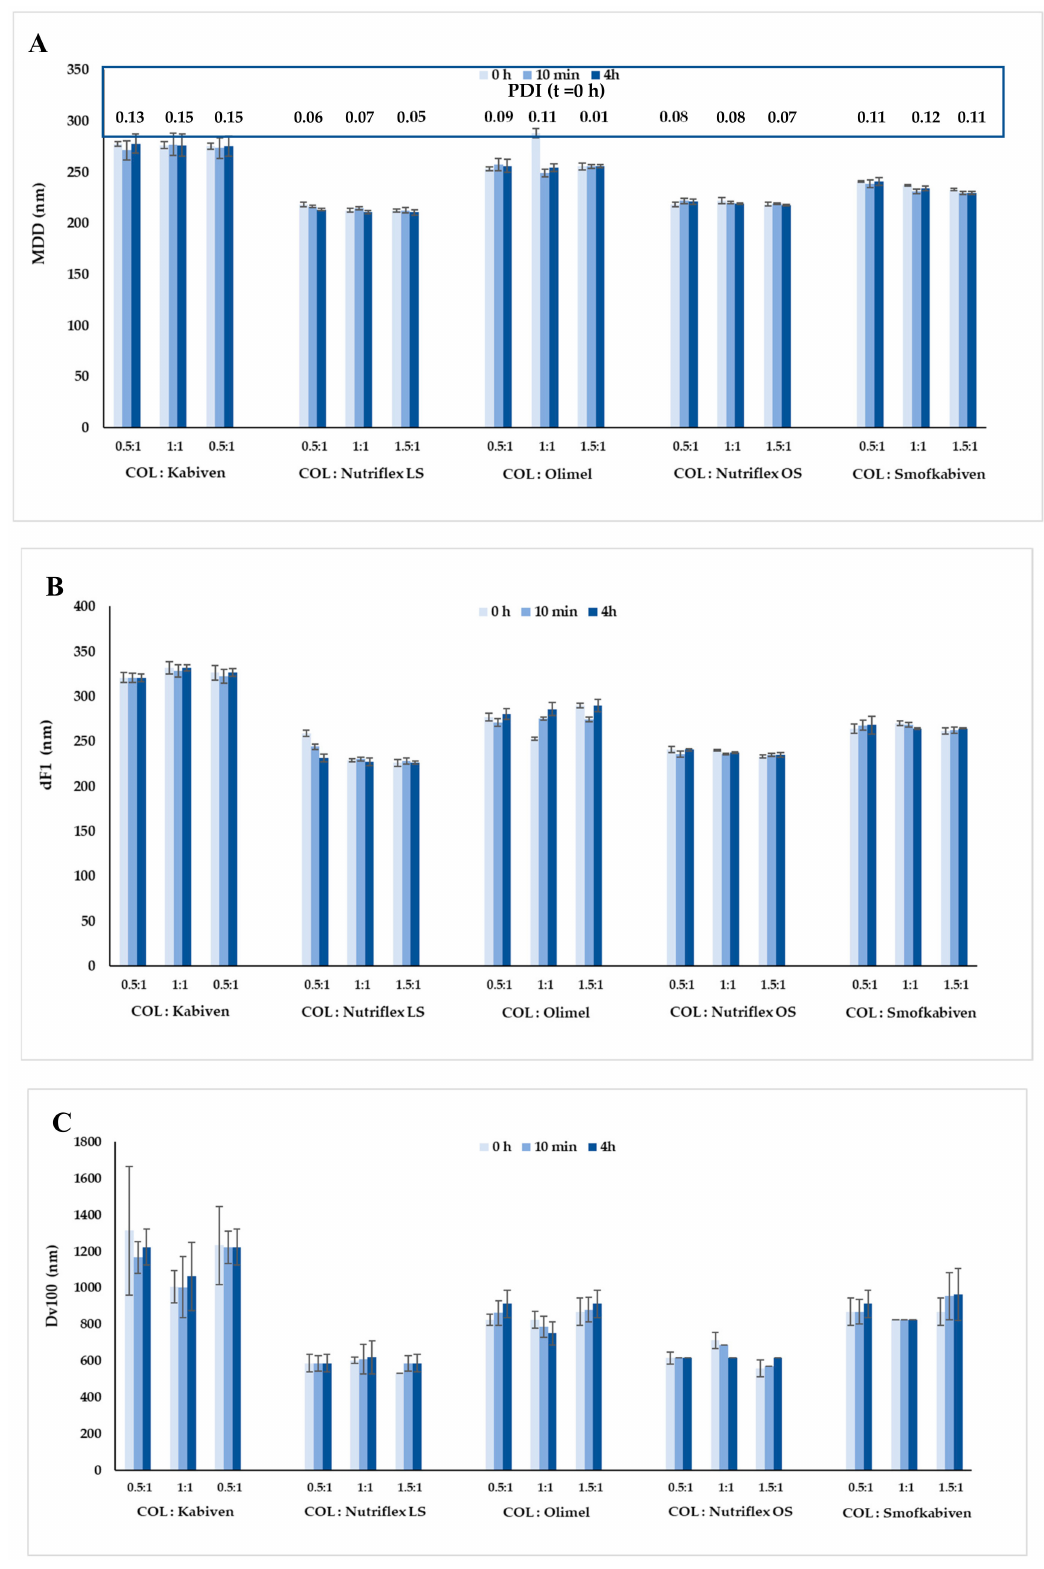
Figure 1. Characterisation of particle size of COL-PN samples: ( A ) MDD; ( B ) dF1, ( C ) Dv100. MDD— intensity weighted mean droplet diameter; dF1—the diameter of the particles present in the highest intensity in the first fraction; Dv100—the diameter below which 100% of the particles lie; PDI— polydispersity